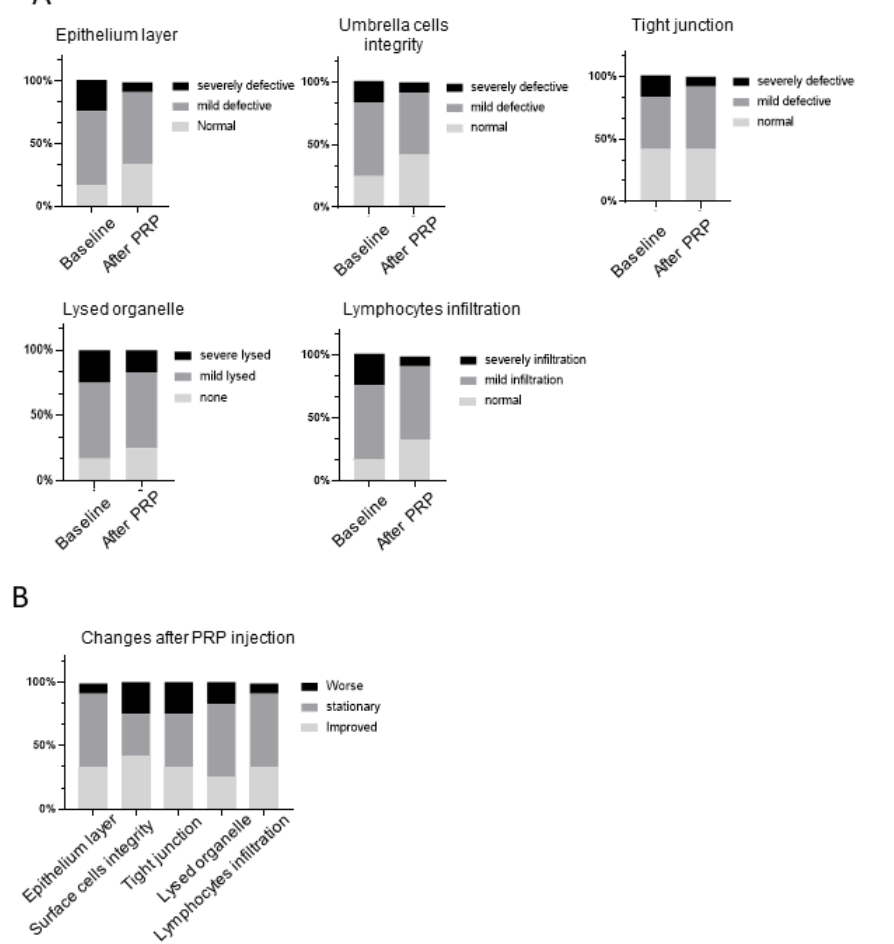
Figure 2. Proportion of bladder ultrastructural defects in patients with rUTI. ( A ) The bladders from patients with rUTI exhibited various ultrastructural defects on EM. ( B ) The proportion of changes in bladder ultrastructural defects in patients with rUTI after intravesical PRP injections.